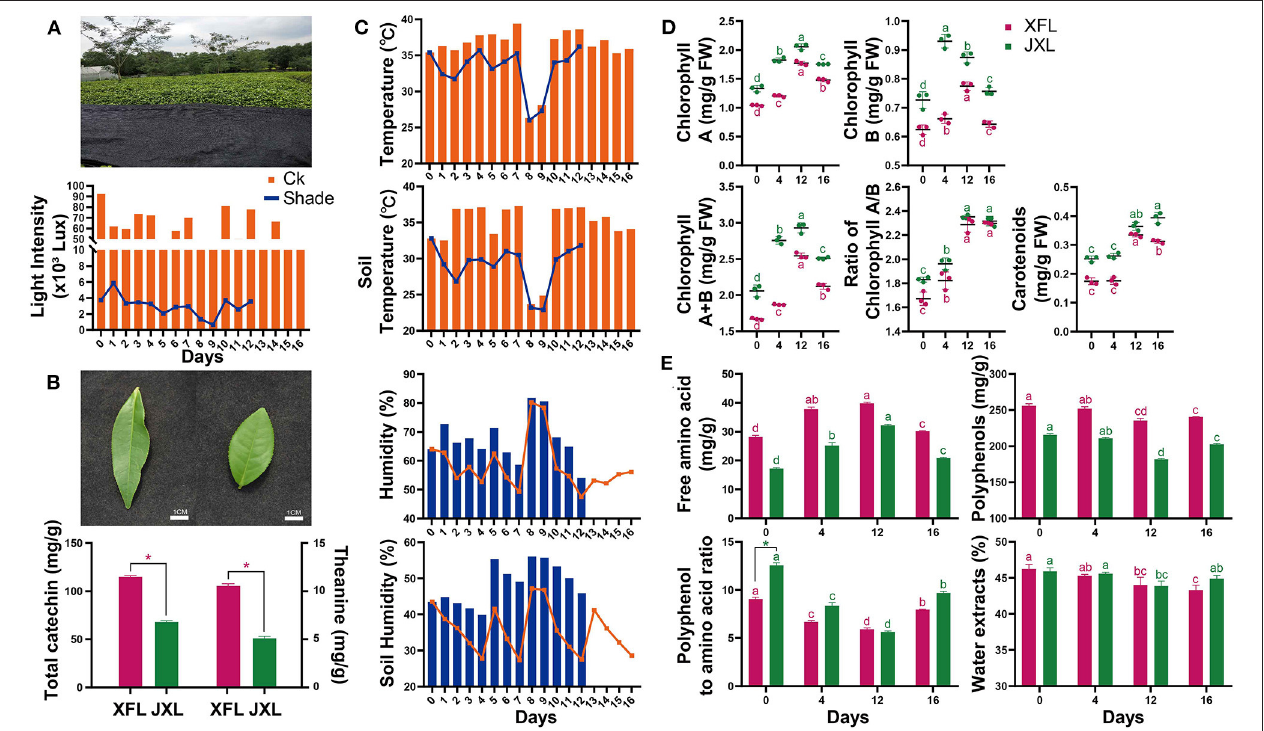
FIGURE 1 | Shading photograph, light intensity (A) , leaf shape, the total catechin and theanine content of two tea cultivars (B) , air temperature and humidity, and soil temperature and humidity (C) were measured of tea plants. The contents of chlorophyll A, chlorophyll B, chlorophyll A/B, total chlorophyll, carotenoids (D) and free amino acids, tea polyphenols, polyphenol:amino acid ratio, and water extract (E) in the leaves of “Xiangfeicui” and “Jinxuan” (mean ± SD, three biological replicates per treatment groups) under shading treatments. Data were assessed by one-way ANOVA followed by Duncan’s multiple range test. * p < 0.05. Ck, control check; Shade, shading treatment; XFL, leaf of “Xiangfeicui” cultivar; JXL, leaf of “Jinxuan” cultivar. Different letters in same color represent p <